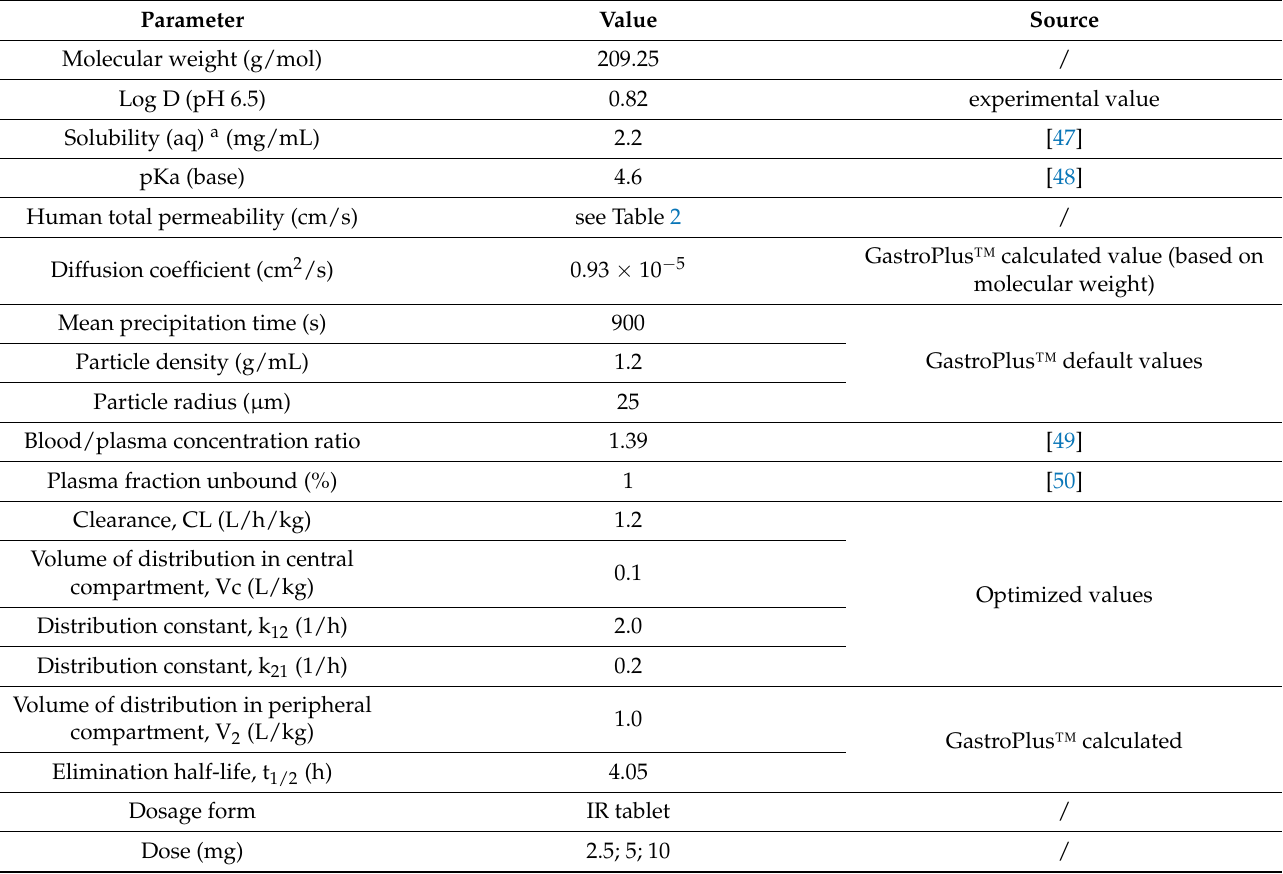
Table 1. The selected input parameters for minoxidil absorption simulation.